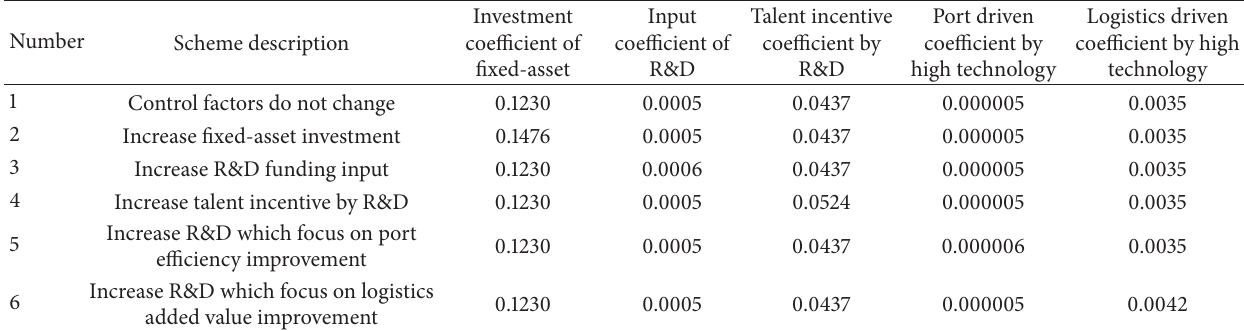
Table 2: The simulation scheme list.